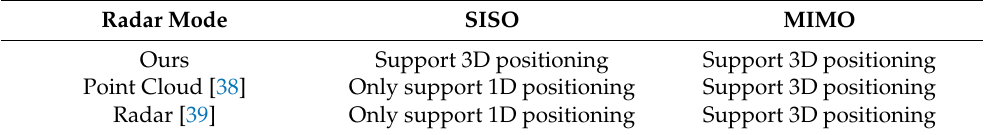
Table 2. Comparison of three